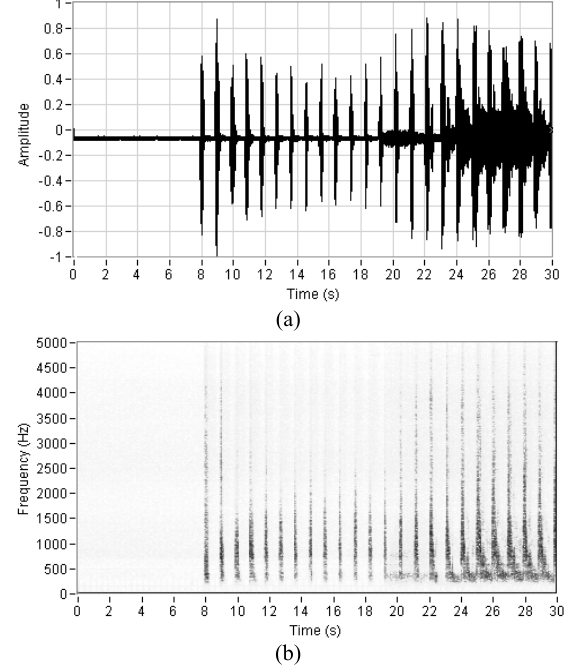
Fig. 10. An example of blood flow (a) and its spectrogram (b) for the brachial artery during the cuff